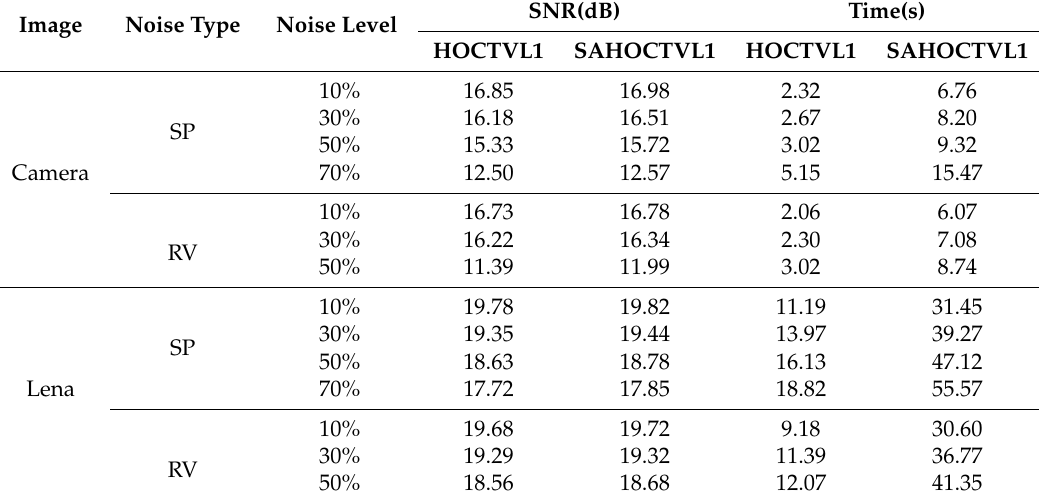
Table 4. Comparisons of SAHOCTVL1 and HOCTVL1 model for Cameraman and Lena corrupted by Gaussian blur and impulse